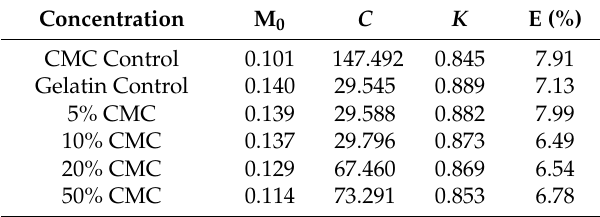
Table 2. GAB equation parameters (single-layer water of films (Mo), relative deviation modulus (E), K and C are the GAB parameters) for cold water fish gelatin films containing CMC at 20 ◦ C. GAB, Guggenheim-Anderson-de